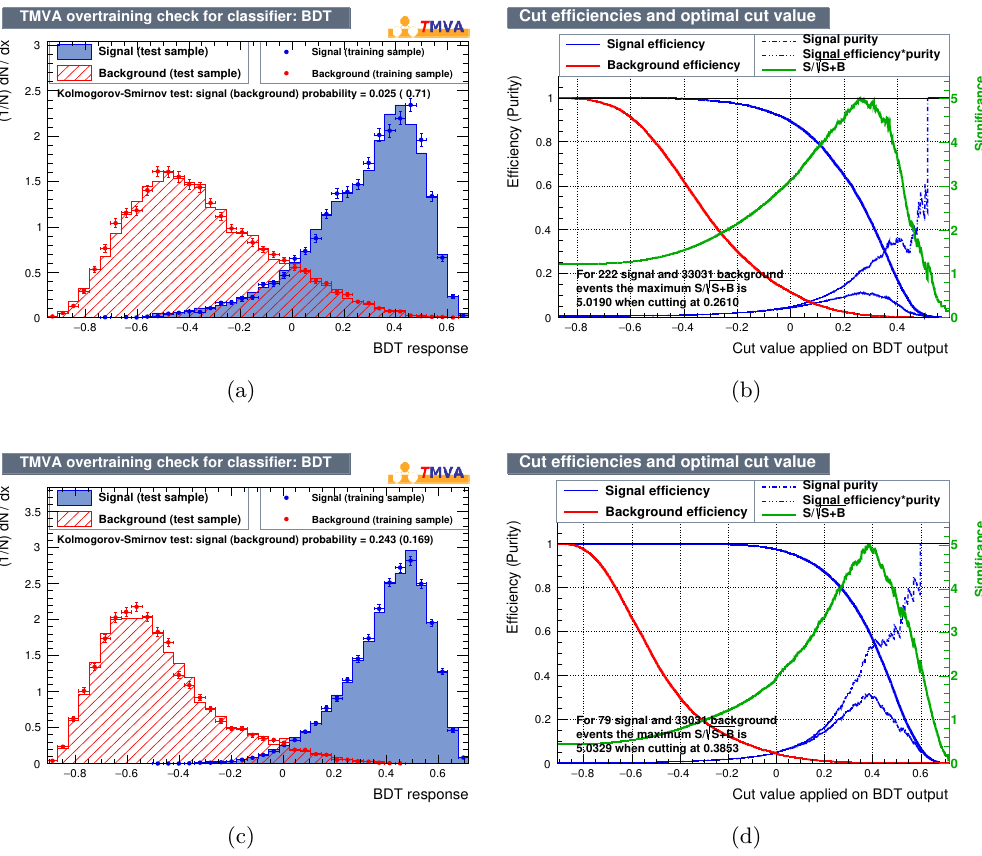
Figure 4 . (a) The BDT response for the signal and the background for m LHC ( p s = 13 TeV) for the 2b-tag category. (b) The corresponding signal and background cut e(cid:14)ciencies and signi(cid:12)cance as functions of the BDT cut. Discovery signi(cid:12)cance of 5 (cid:27) is achieved for the optimal BDT cut, BDT opt & 0 : 26. Similar (cid:12)gures for m